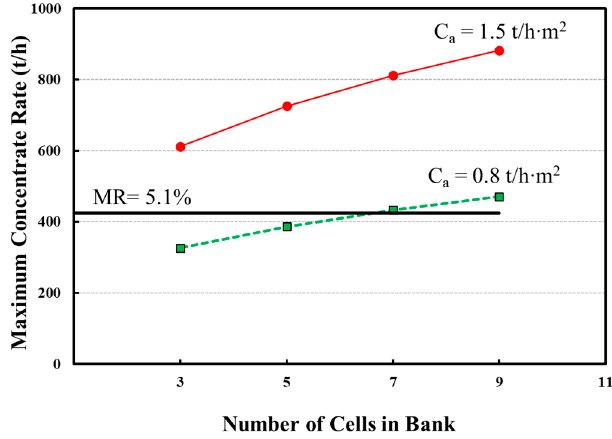
Figure 1. Bank maximum concentrate rate as a function of number of cells; target concentrate rate for given mass recovery (MR) (see text).